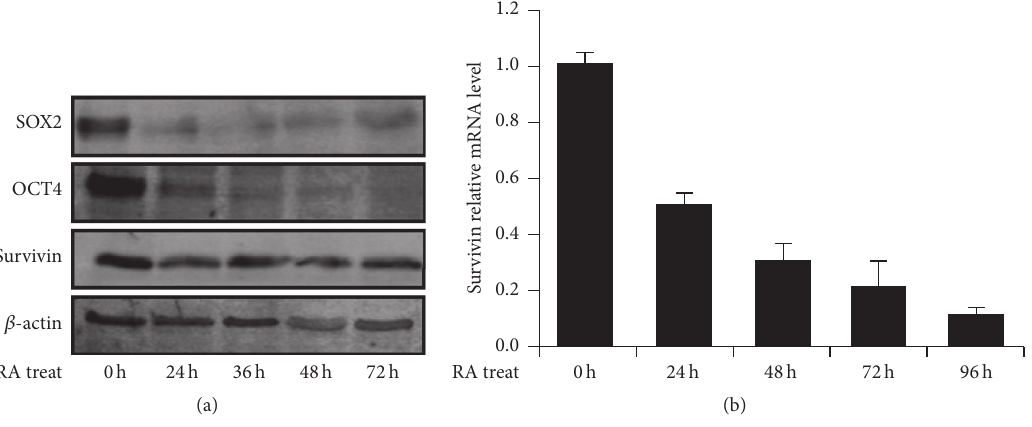
Figure 7: The expression of Survivin was decreased with ES cell differentiation. (a) Expression of Survivin was downregulated with ES cell differentiation with Retinoic Acid (RA). The cells of 0h, 24 h, 36 h, 48h, and 72 h were collected for Western blot analysis. The proteins of SOX2, OCT4, and Survivin were analyzed in RA-treated differentiation and 𝛽 -actin as housekeeping control. (b) The change of Survivin mRNA levels in the process of RA-treated differentiation for ES cells. The expressions of mRNA decreased gradually and sharply with prolonged RA-treatment